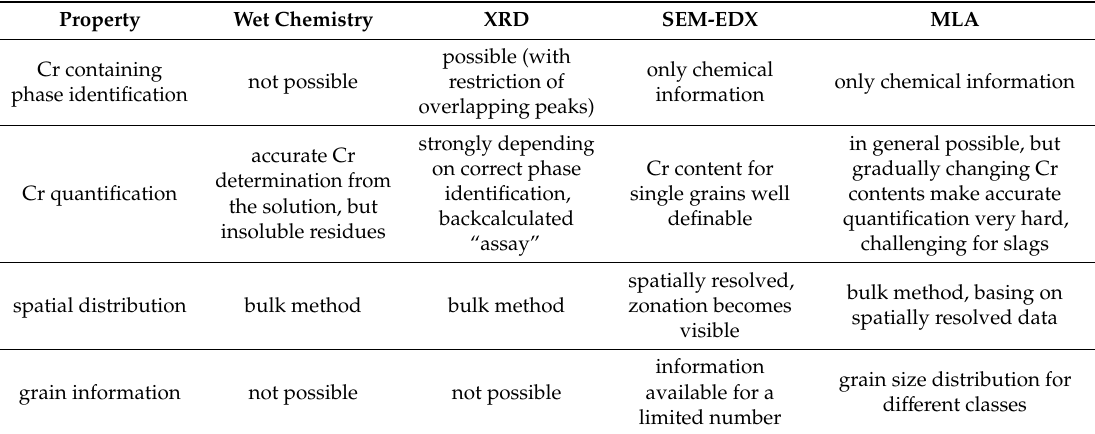
Table 4. Summarizing the capabilities of the used methods (MLA is named here vicarious for similar methods such as QEMSCAN, TESCAN TIMA